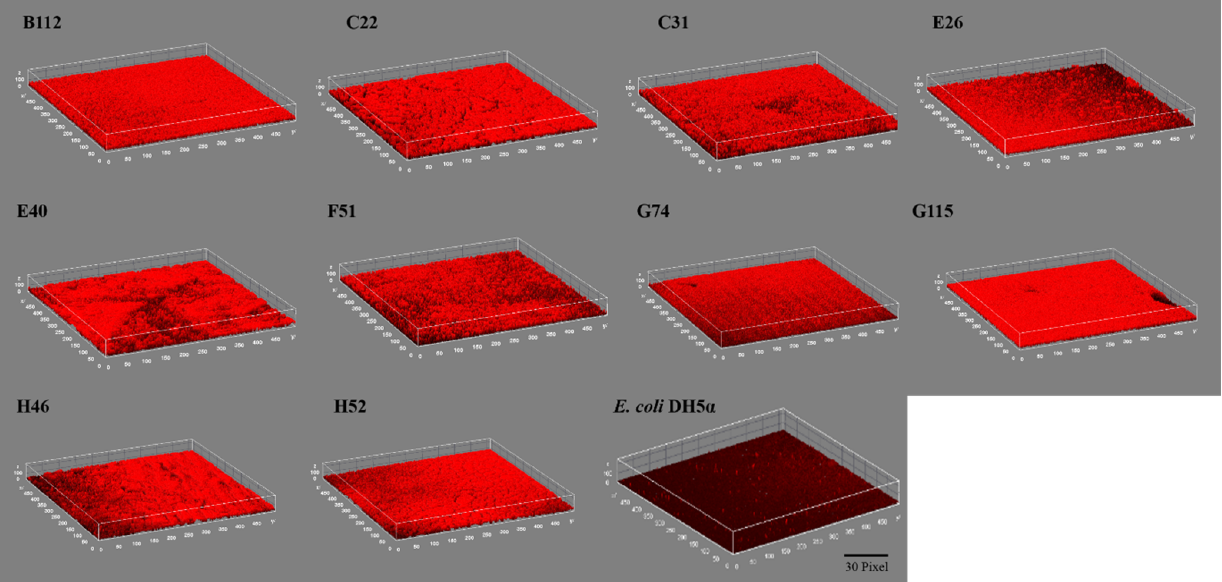
Figure 4. Confocal laser scanning microscope (CLSM) photomicrographs of 10 QS bacteria biofilms grown in 2216E liquid medium. All photomicrographs were taken at 72 h. E. coli DH5a was the negative control. Dyes of propidium iodide, wavelength of 559 and 570–670 nm and ×20 magnification were used to observe. Scale bar was 30 Pixel.